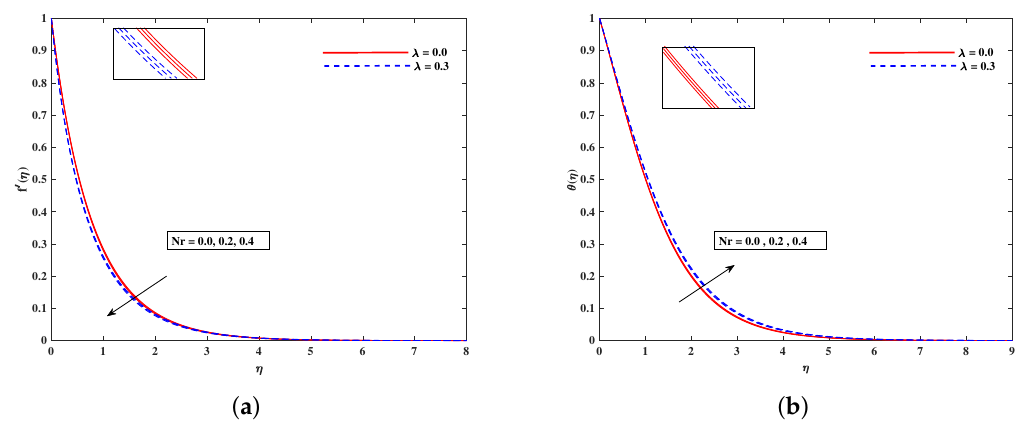
Figure 5. Fluctuation of Nr on velocity f (cid:48) ( η ) ( a ) and temperature profile θ ( η ) ( b ).